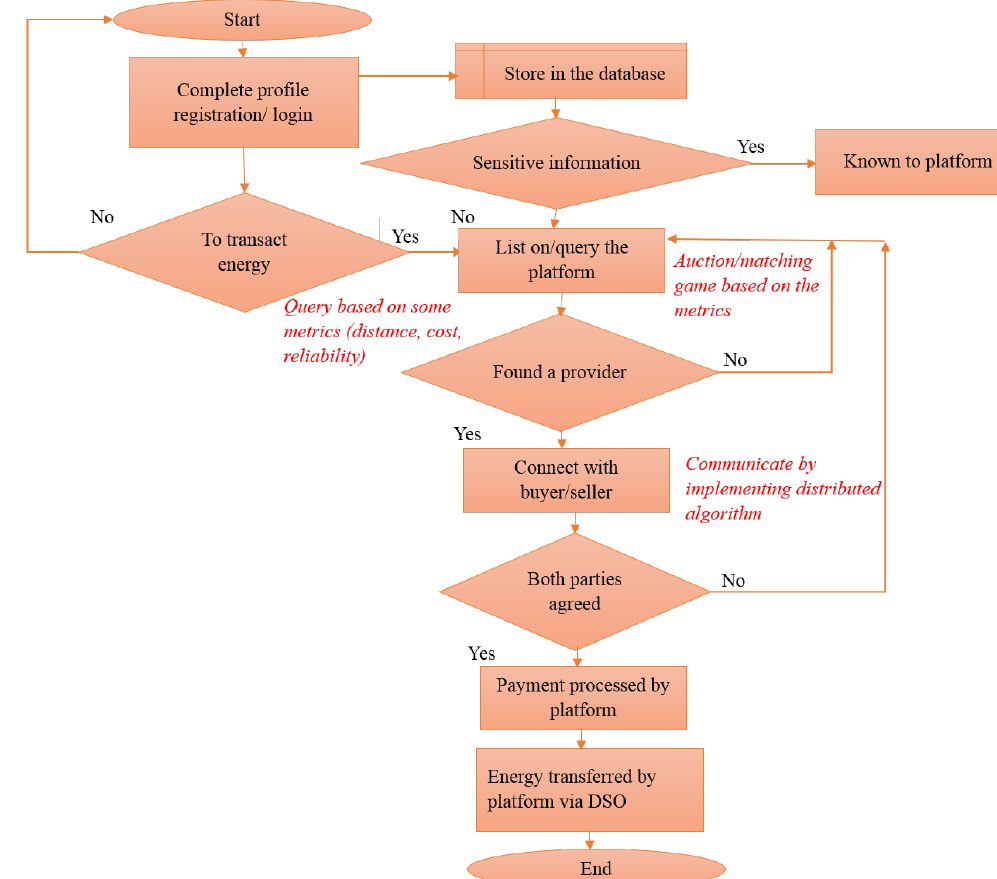
Figure 6. A proposed platform algorithm for distributed energy transaction and management.